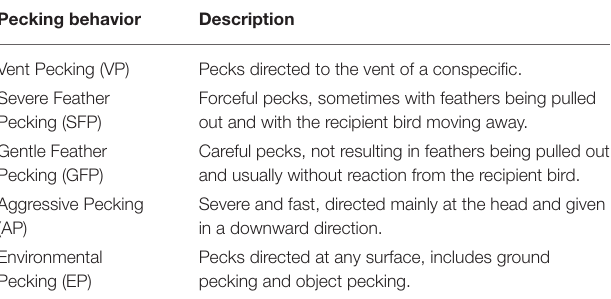
TABLE 3 | Ethogram of continuous observations of pecking behavior [(31) modified]. Pecking behavior